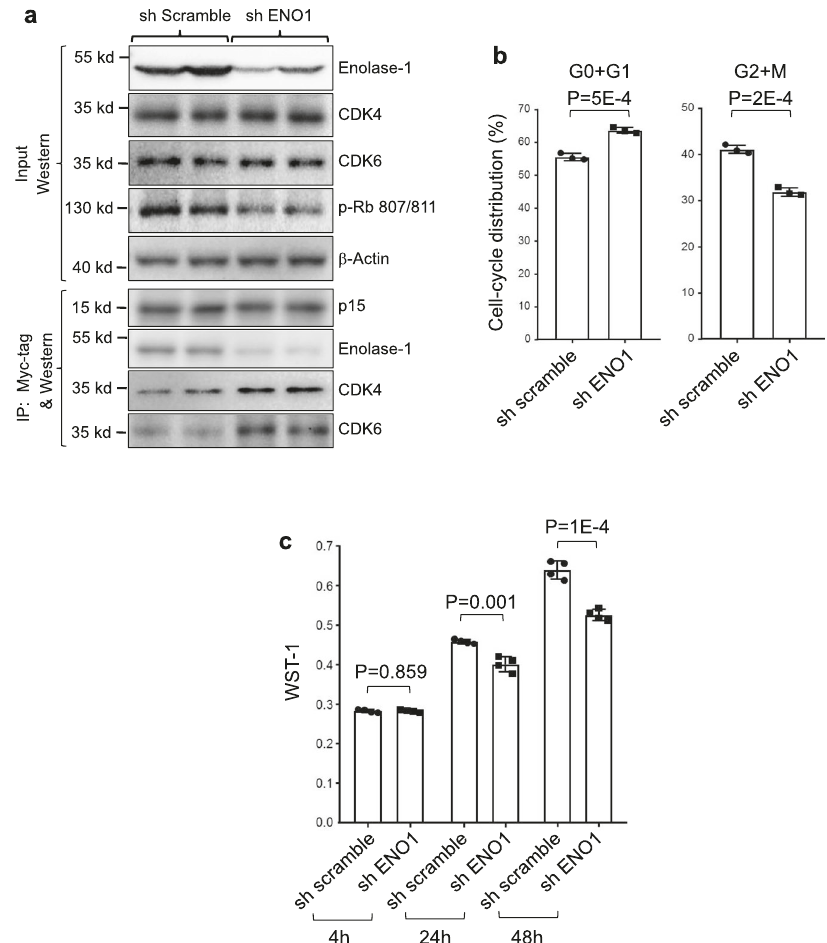
Fig. 9 Down-regulation of enolase-1 reduces bladder cancer cell proliferation. a knockdown of enolase-1 by shRNA in UMUC3 cells leads to increased binding of p15 to CDK4 and CDK6 as evidenced by immunoprecipitation followed by western blotting. The two lanes represented two stable clones from each of scrambled control and enolase-1 shRNA. Source data are provided as a Source Data fi le. b , c Reduced enolase-1 was associated with reduced cell-cycle progression and increased cell proliferation. n = 3 and 4 for b and c , respectively, of biologically independent samples. Data are presented as mean values±SD. Two-sided t -test was performed to compare the signi fi cance of the difference between the two groups (p15 versus p16). Experiments were repeated three times with similar